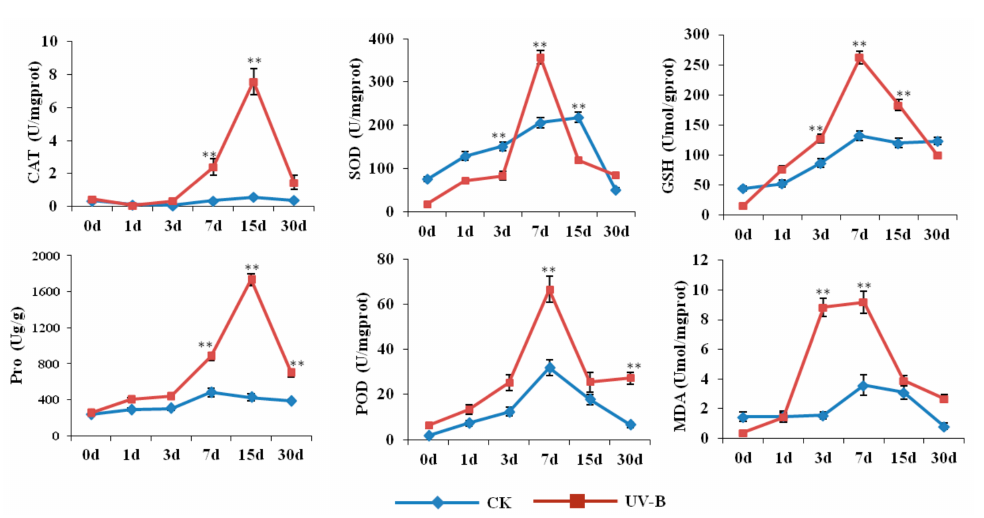
Figure 1. Comparison of physiological indices of the roots of M. himalaica from the UV-B radiation and control check (CK) groups. The abscissa is the treatment time for M. himalaica from pre-treatment (Day 0) to Day 30 after treatment. The ordinate indicates the different enzyme activities or substance content. CAT: catalase; SOD: superoxide dismutase; GSH: glutathione; Pro: proline; POD: peroxidase; MDA: malondialdehyde. The “**” represented the significant difference level between treatments ( p -value < 0.01).